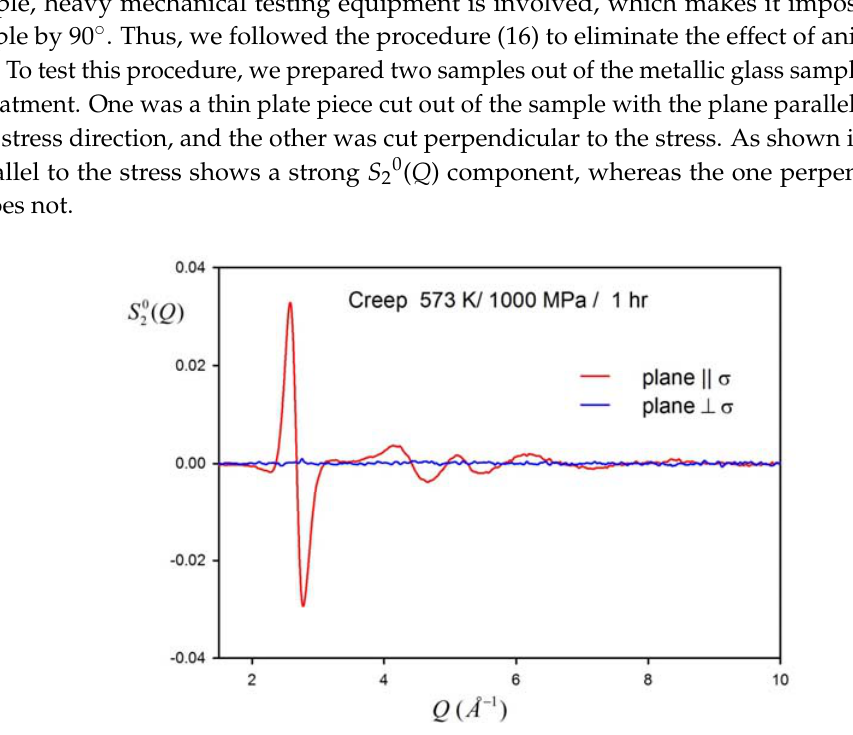
Figure 6. The S 2 0 ( Q ) determined for two cross ‐ sections of the sample after the creep treatment: With Figure 6. The S 20 ( Q ) determined for two cross-sections of the sample after the creep treatment: With the plane parallel to axial stress and plane perpendicular to the uniaxial stress. the plane parallel to axial stress and plane perpendicular to the uniaxial